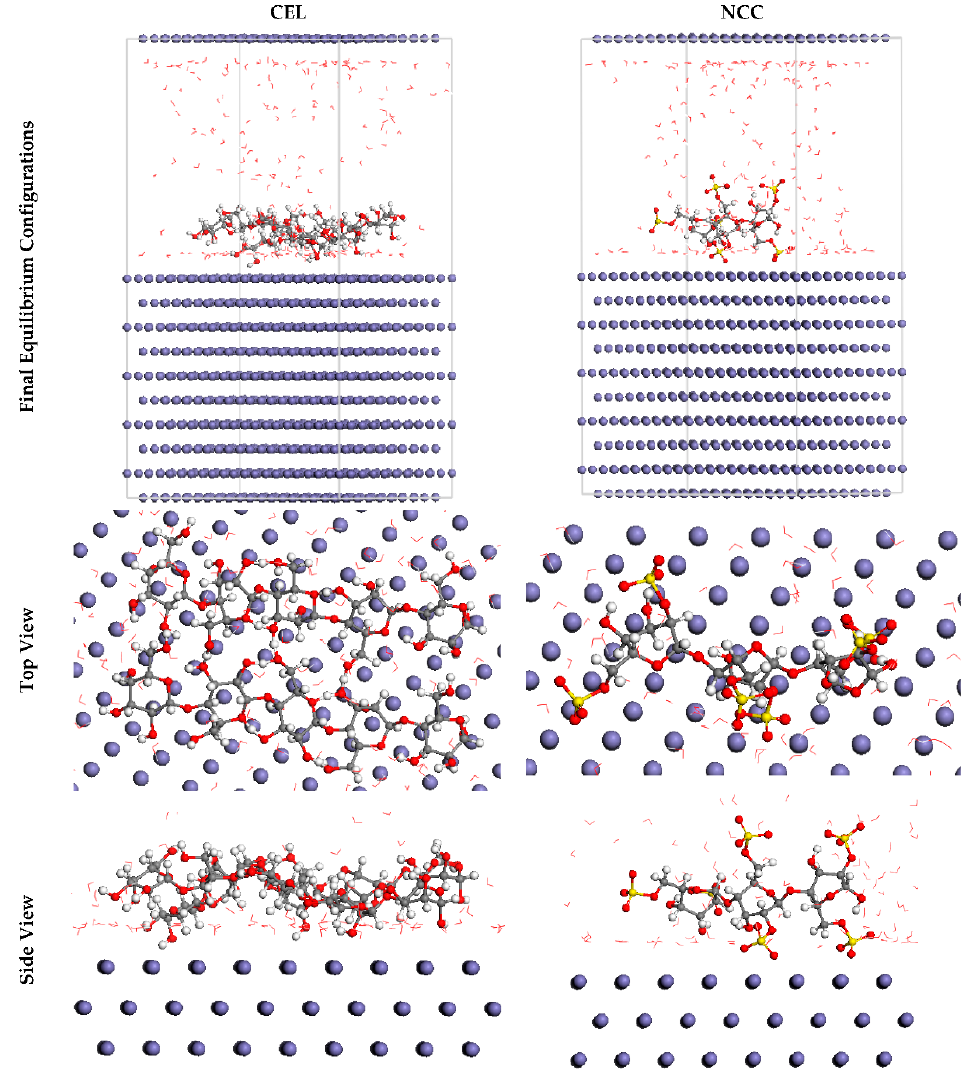
Figure 11. The optimal arrangement for adsorption of the CEL and NCC over the Fe (1 1 0) surface attained through the adsorption locator array. Reprinted with permission from Ref. [8]. MDPI